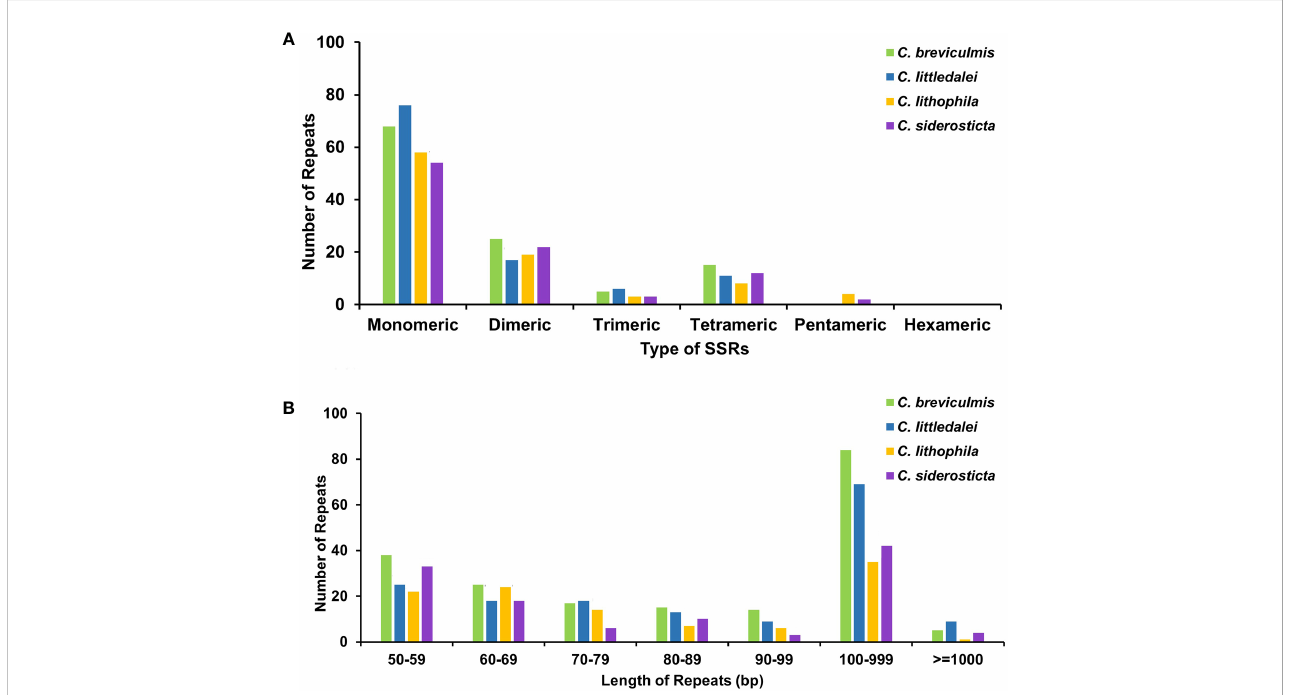
FIGURE 3 Statistics of the repeats in the four Carex chloroplast genomes. (A) Analysis of microsatellite repeats. (B) Analysis of dispersal repeats based on ROUS